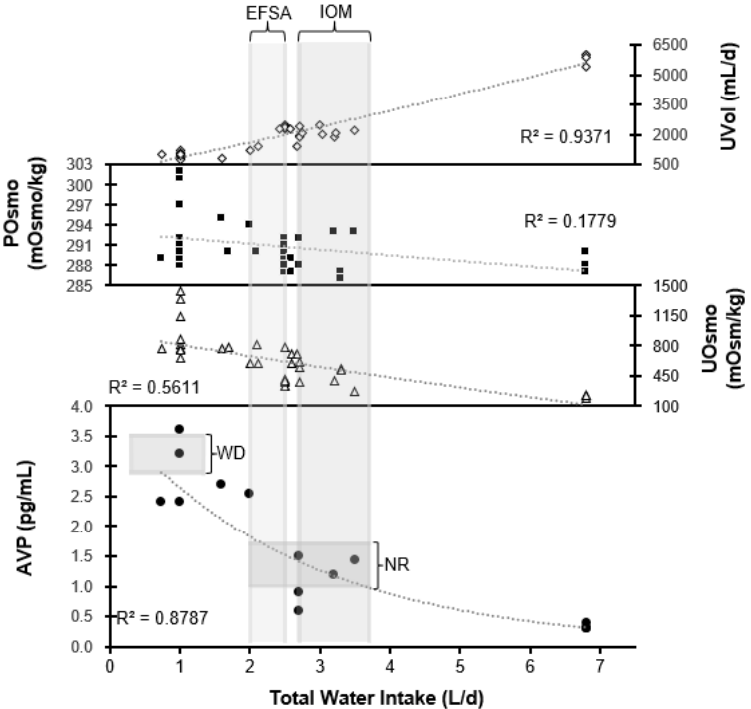
Figure 6. Urine volume (U VOL ), plasma osmolality (P OSM ), urine osmolality (U OSM , 24h), and plasma AVP plotted against daily total water intake. EFSA and NAM water Adequate Intakes are shown as the vertical shaded column. AVP concentrations associated with water restriction (WR) and baseline resting total water intake (B) (Table 7) appear as horizontal shaded rows. All data points are group mean values (SD not shown) from investigations that measured TWI.